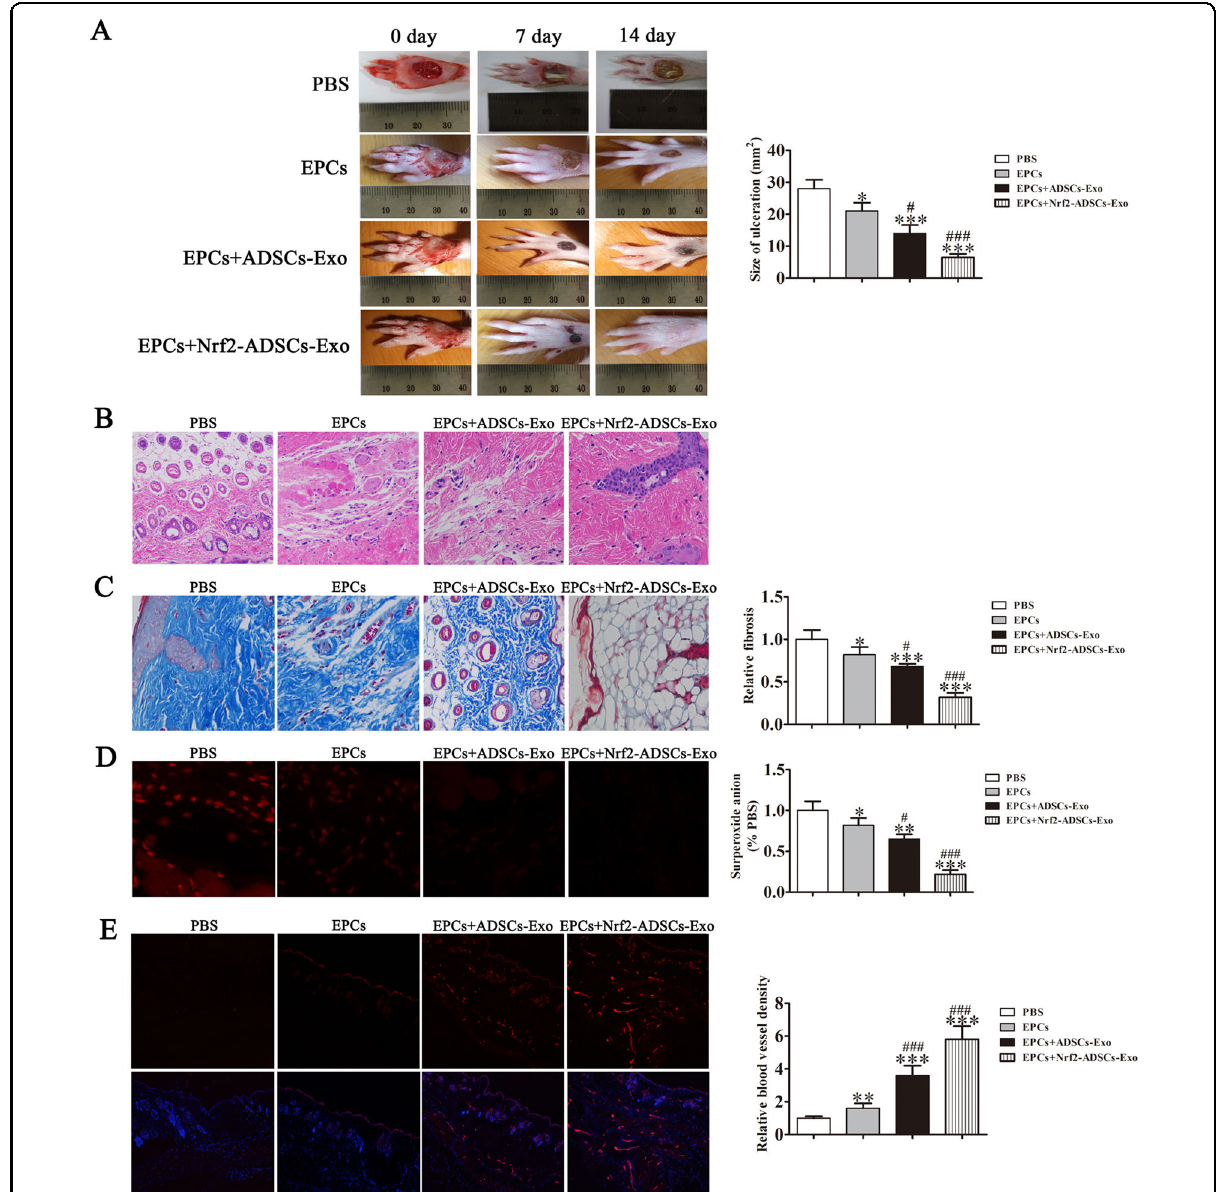
Fig. 7 Comparison between treatments by EPCs combined with or without exosomes from adipose-derived stem cells (ADSCs) and Nrf2- ADSCs. a Representative images of full-thickness skin defects in a diabetic rat model treated with EPCs alone or combined with exosomes derived from ADSCs (ADSCs-Exos) or ADSCs overexpressing Nrf2 (Nrf2-ADSCs-Exo) for 0, 7, and 14 days postoperatively. Scale bar: 10 mm. Percentage wound closure of different groups. * P < 0.05 compared with control. b Granulation tissues in the different treatment groups were measured with H&E stain. c Collagen deposition and tissue fi brosis were assessed with Masson Trichrome staining. d Intracellular ROS levels were determined by immuno fl uorescence using DCH-DA stain. Scale bar, 40 μ m. e Immuno fl uorescence with CD31 staining shows microvascular formation. Scale bar, 40 μ m. The relative protein levels were analyzed, and data are presented as the mean ± SD ( n = 6). * P < 0.05, ** P < 0.01, *** P < 0.001 vs. PBS; # P < 0.05, ### P < 0.001 vs.